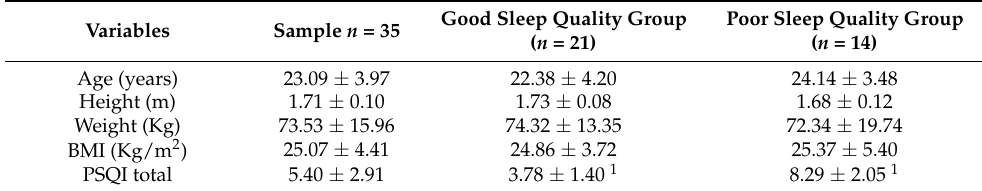
Table 1. Anthropometrics characteristics and total PSQI score of the total sample and sleep quality groups (mean ± SD).